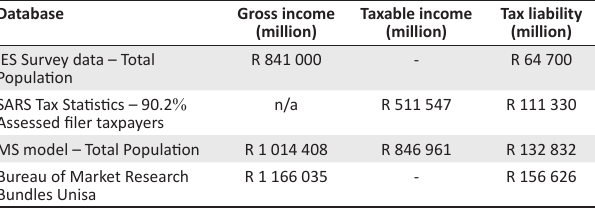
TABLE 3: Comparison of Income and Expenditure Survey, micro-simulation model and South African Revenue Service for the survey year 2005/2006. Database